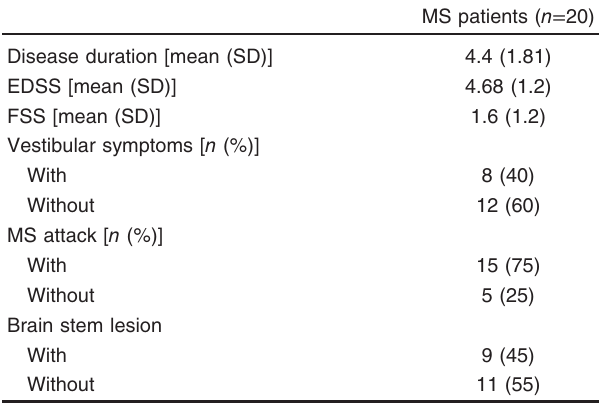
Table 2 Disease characteristics in patients with multiple sclerosis